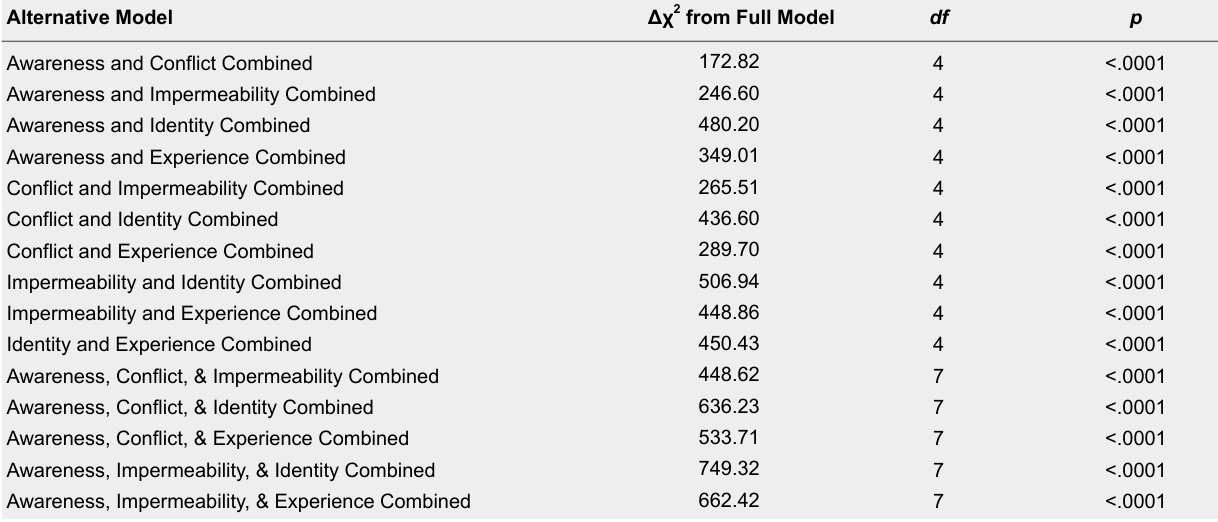
Summary of Model Comparisons Between the Full Five Factor Model and All Simplified